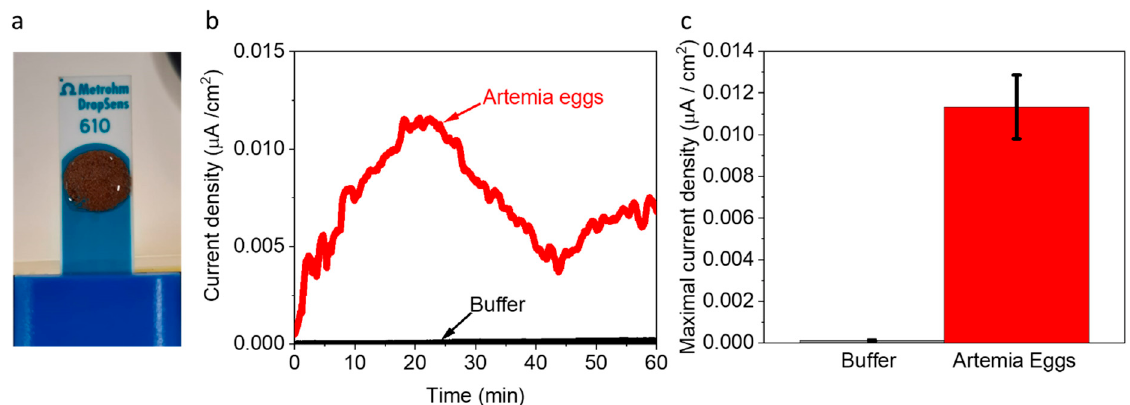
Figure 3. Artemia eggs produce an electric current in a BEC. Chronoamperometry measurements of Artemia ’s eggs and the pure buffer under an applied potential of 0.5 V to the WE. ( a ) Picture of the measurement setup. The Artemia eggs (brown spots) entirely cover the surface of screen-printed electrodes. ( b ) Chronoamperometry measurements of the buffer (black) and Artemia eggs (red). ( c ) Maximal current densities of buffer (black) and Artemia eggs (red). The error bars represent the standard deviation over three independent repetitions.